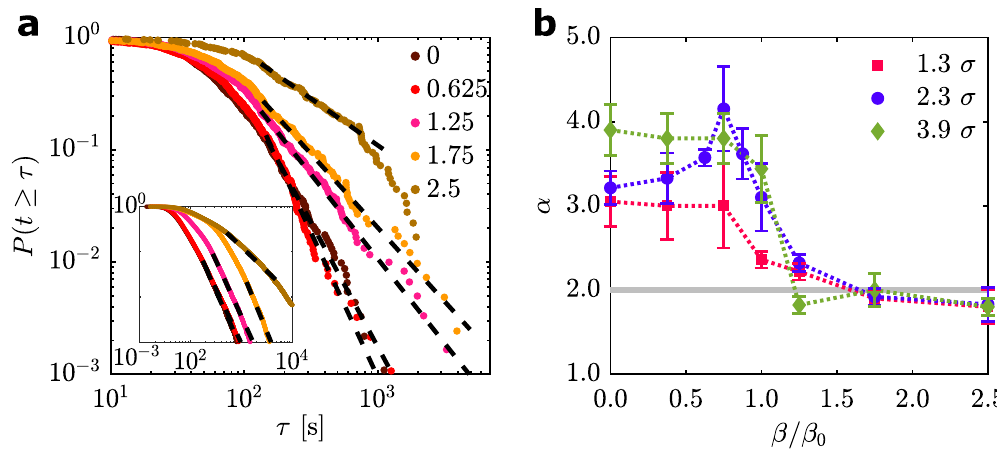
Figure 3. Cumulative distribution functions. ( a ) The complementary cumulative distribution functions P ( t ≥ τ) of time τ between subsequent particle registration events as obtained from experiments with θ = 90 ◦ and d = 2.3 σ . Different colours refer to different values of β/β 0 . The dashed lines are power-law fits, the start of the power law section and the corresponding exponent was obtained using the procedure proposed in 36 . The obtained exponents are for increasing β : α = 3.2, 3.6, 2.3, 1.9, 1.8 . The inset shows the corresponding simulation data with exponents: α = 3.5, 3.4, 3.5, 3.7, 2.1 . ( b ) Exponents as extracted from experimental CDF fits for bottlenecks with θ = 90 ◦ and varying d . Colours refer to values of d . For information about the determination of uncertainties, see